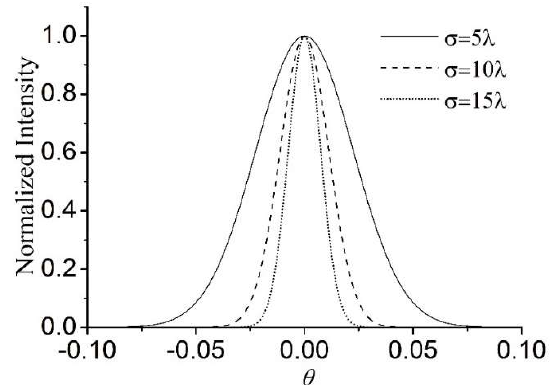
Figure 2. The normalized intensity of the scattered partially coherent Gaussian Schell-model plane-wave pulse versus θ for different values of σ of the deterministic spherical scatterer.